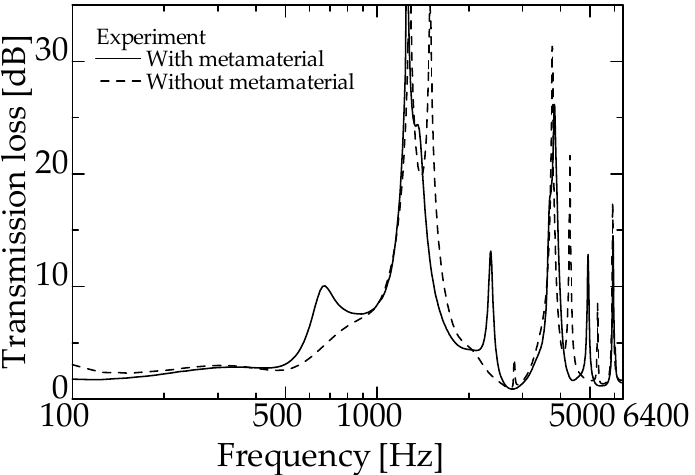
Figure 12. Comparison of the experimental values with and without zero-mass metamaterial (zero- mass metamaterials at L da = 60 mm).